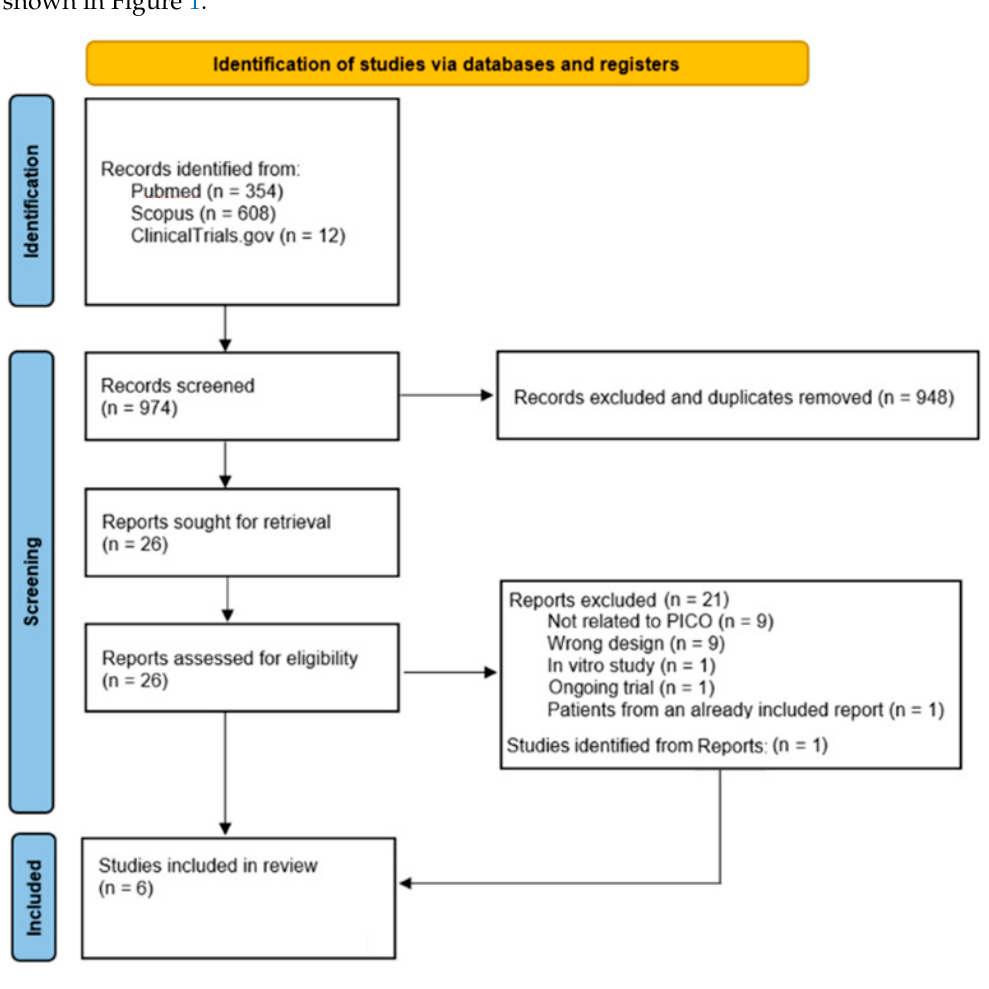
Figure 1. Flowchart of study selection